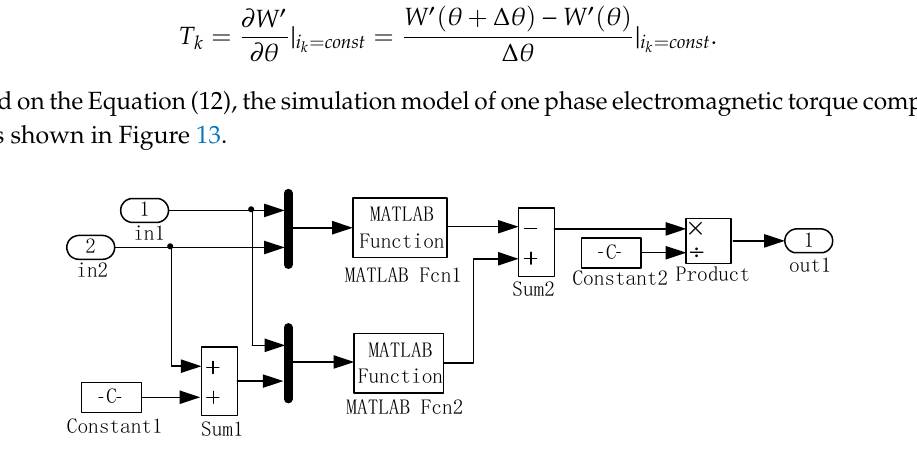
Figure 13. One phase electromagnetic torque calculation module.